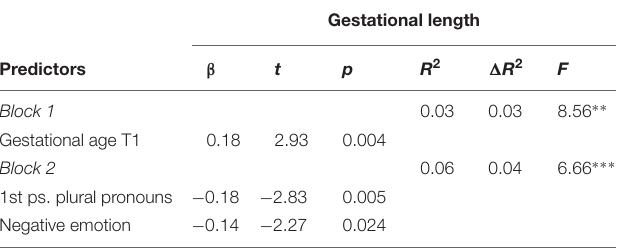
TABLE 3 | Block-wise regression analysis for gestational length.